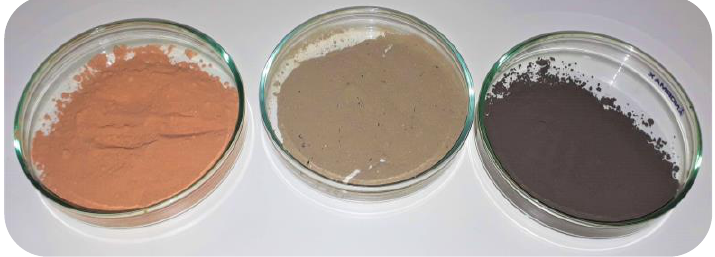
Figure 1. Used GPC precursors. From left to right: MK, BFA, and ground EAFS. MK used in this research was supplied by Mota Ceramic Solutions (Portugal), while the used BFA originates from a plant of Greenvolt (Lisboa, Portugal), where it was separated from the gaseous stream by bag filters. Both MK and BFA are originally powdered materials and were used as received. As for EAFS, the material was supplied by Harsco Environmental (Maia, Portugal) and was composed of large granules (as large as 5 cm, in our case) that are not suited for use in the geopolymerization process. For this reason, the original material was ground in a laboratory mill (MGS, Rapid Mill MGS1800/2) to produce the fine powder needed for the GPC preparation. The specific gravity of MK, BFA, and EAFS, provided by the suppliers, is 2.4, 2.3, and 3.5, respectively. The particle size distribution (PSD) curves and the main PSD parameters for each used precursor, determined in a Masterziser 3000 laser diffraction particle size analyzer (Malvern Panalytical, Malvern, UK), are shown in Figure 2 and Table 1, respectively.